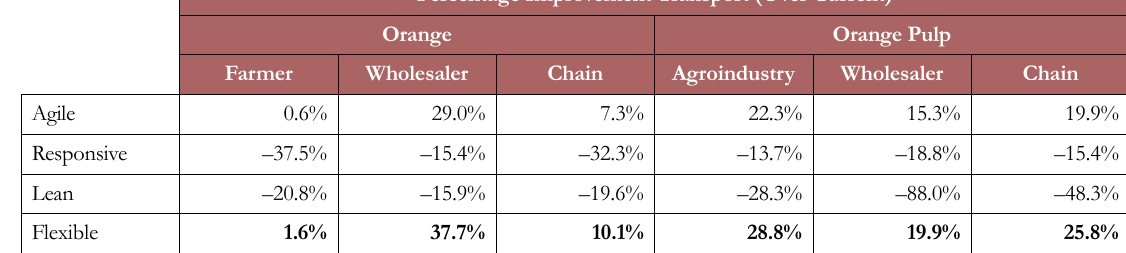
Table 8b. Percentage Change transport for Orange